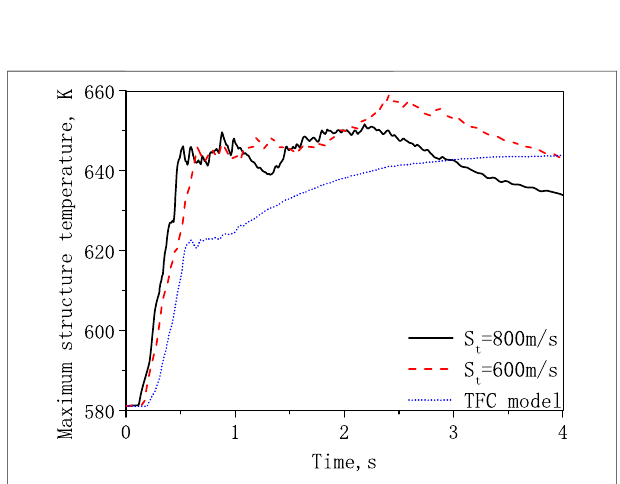
Frontiers in Energy Research |